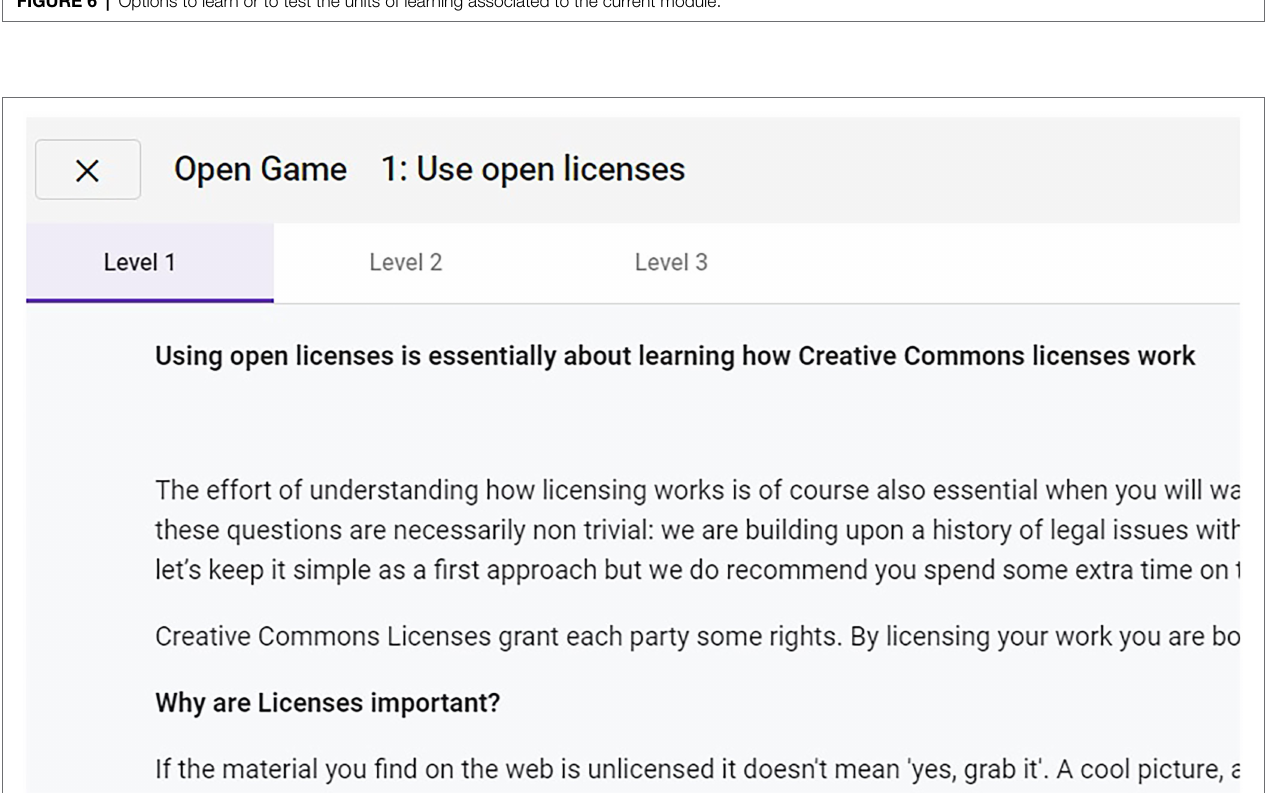
FIGURE 6 | Options to learn or to test the units of learning associated to the current module.